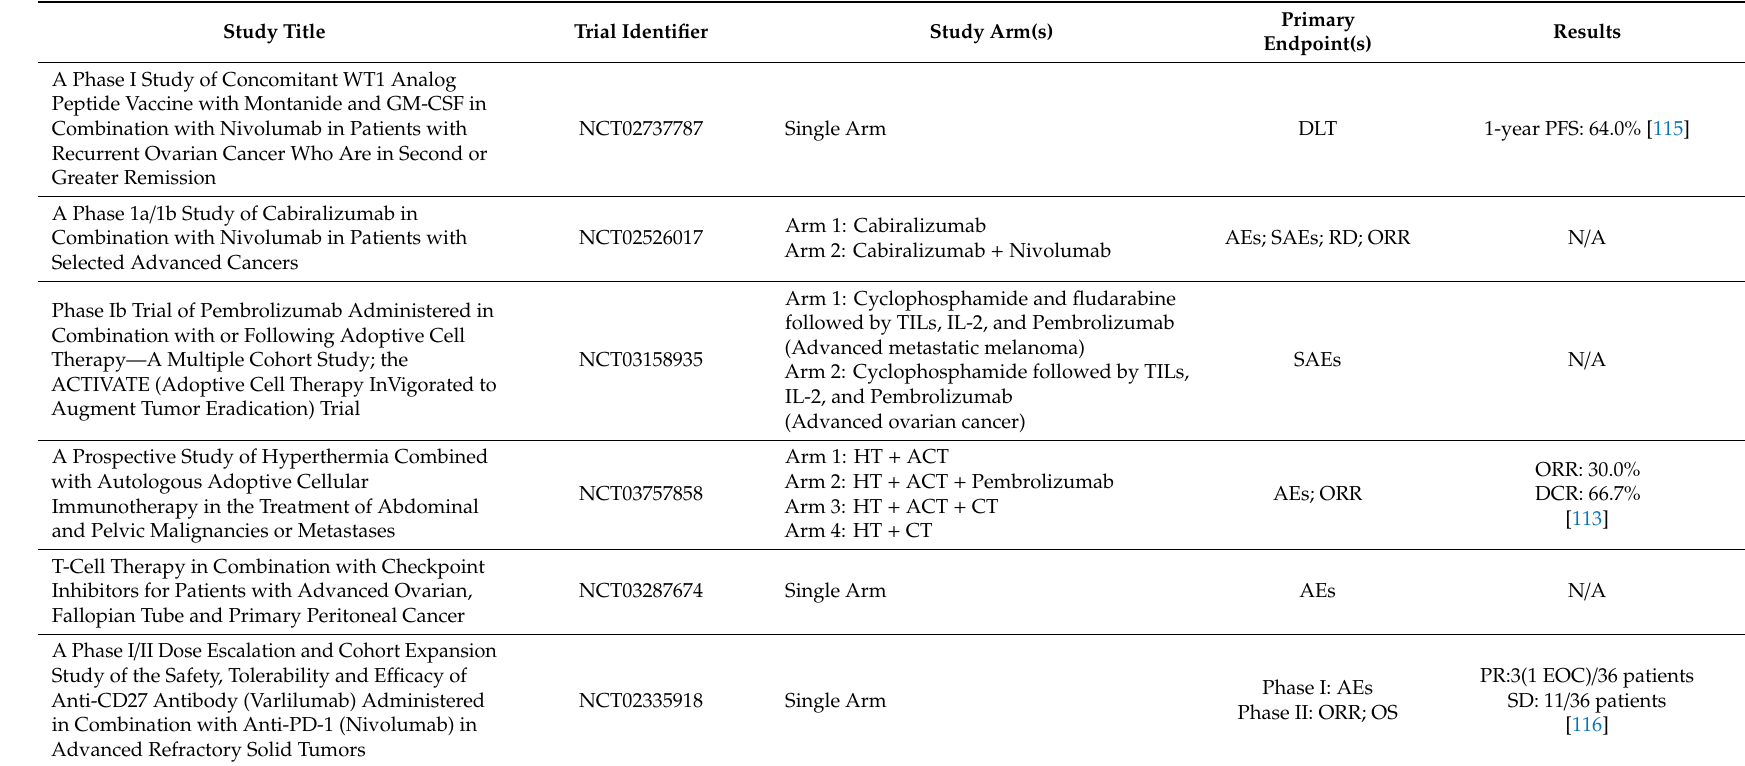
Table 5. PD-1 and novel